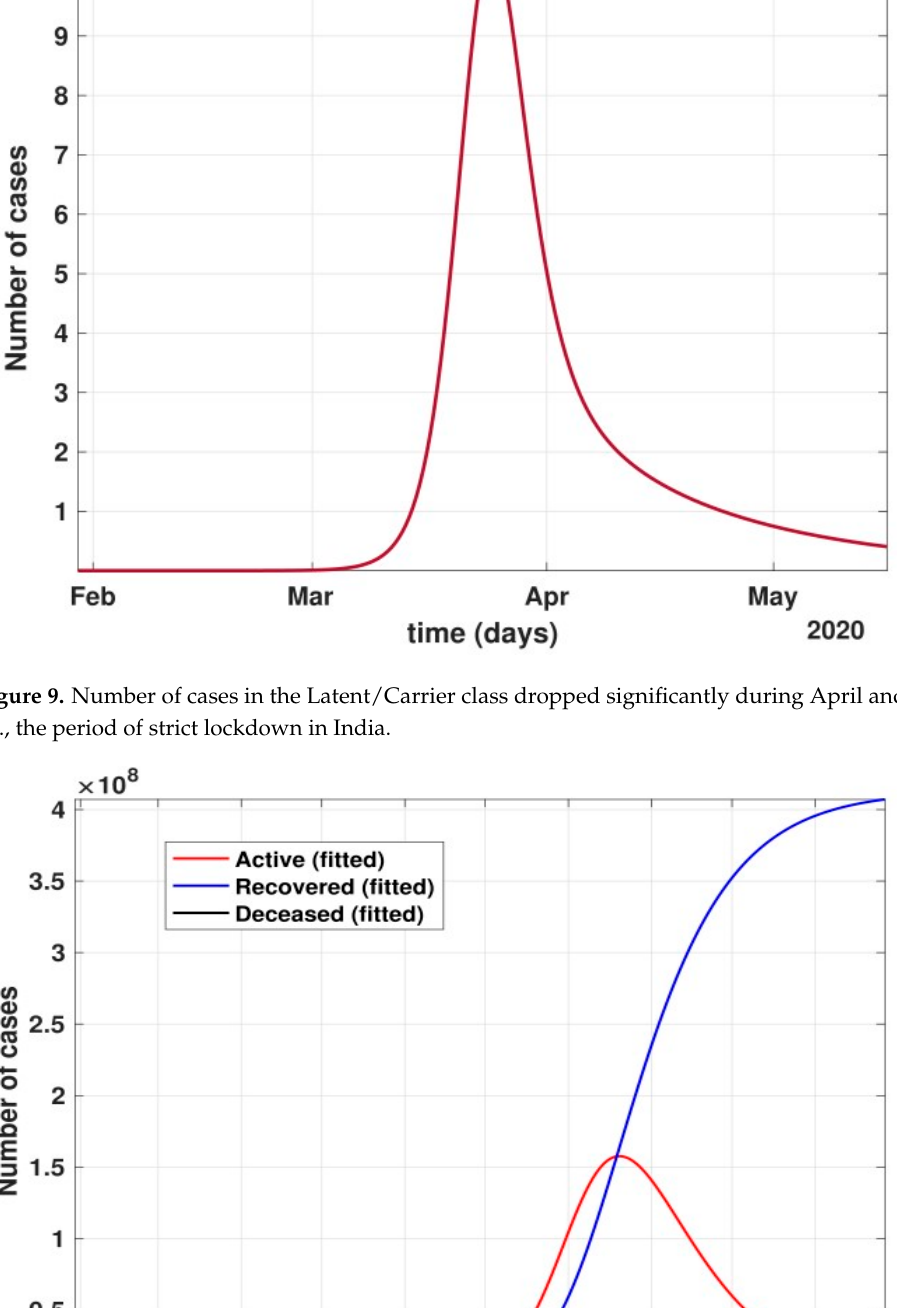
Figure 11. Prediction of the proposed model (1) for the number of COVID-19 cases in 2021 (second wave).